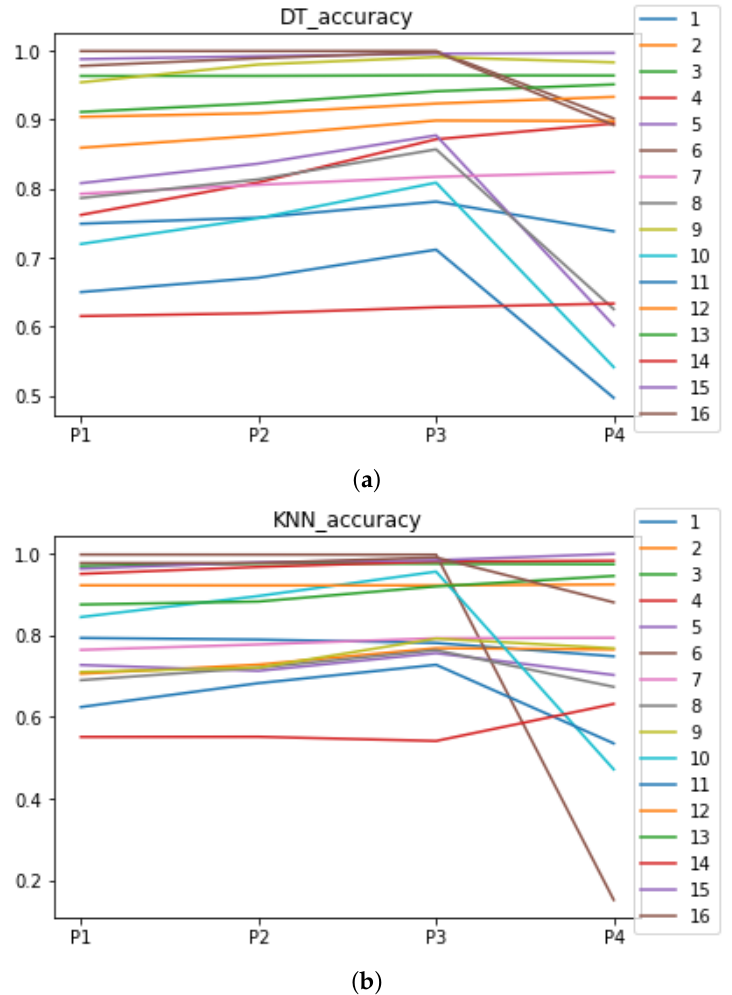
Figure A1. Behavior of RHOASo: accuracy. Each line represents a dataset. ( a ) Accuracy for DT. ( b ) Accuracy for